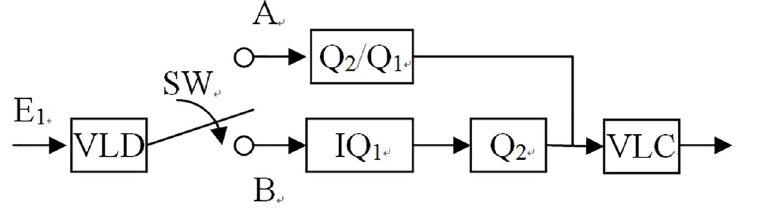
Fig 9. Modified I-pictures transcoding